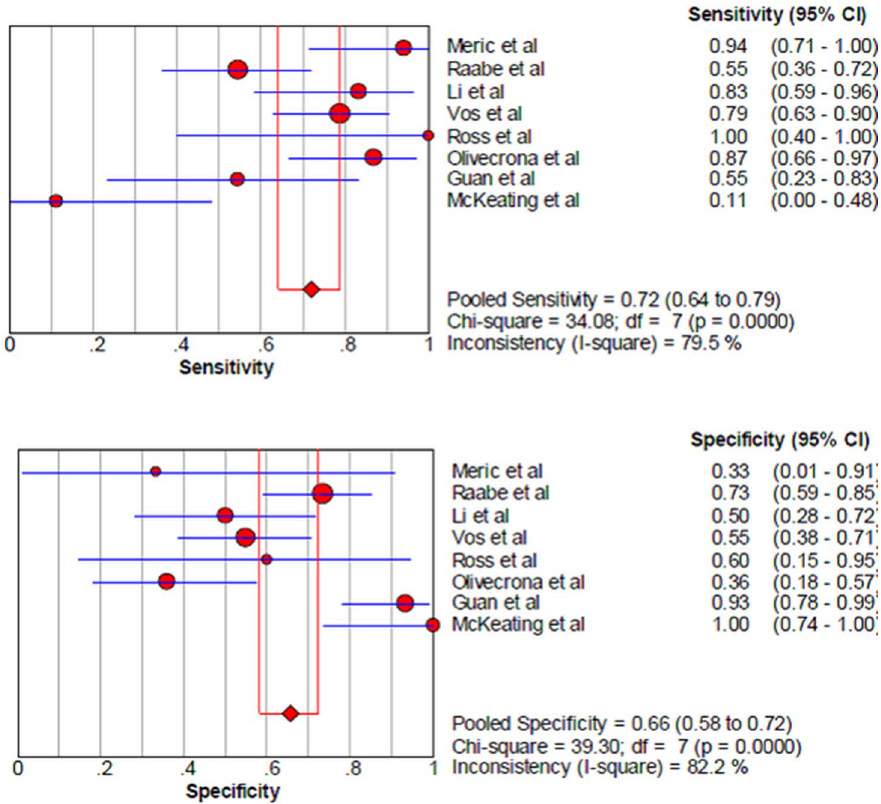
Figure 7. The pooled sensitivity and specificity to predict unfavourable outcome in patients with traumatic brain injury.